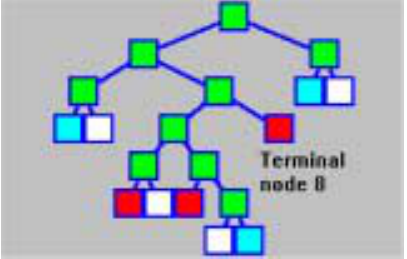
Fig. 1. CART (Classification and Regression Tree) for the detec- tion of connective tissue of the reticular dermis, derived from the learning set of 10240 elements. Non-terminal nodes appear green, terminal nodes consisting mainly of connective tissue elements ap- pear red, terminal nodes consisting of other tissue elements appear blue. Nodes which do not contain a significant majority of one of the classes appear pale. The majority of elements classified as connec- tive tissue is found within one terminal node (terminal node